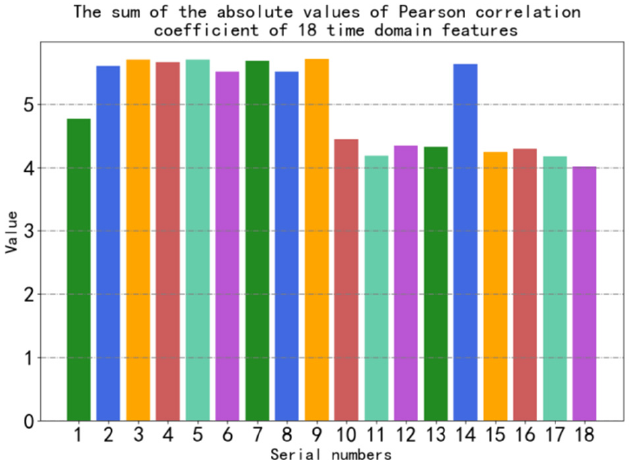
Figure 4. The sum of the absolute values of Pearson correlation coefficient of 18 time domain fea- tures.